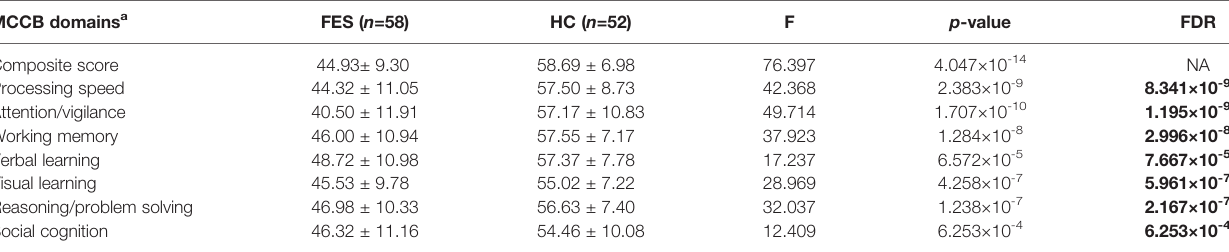
TABLE 2 | Comparison of the MCCB scores between fi rst-episode schizophrenia patients and healthy controls. MCCB domains